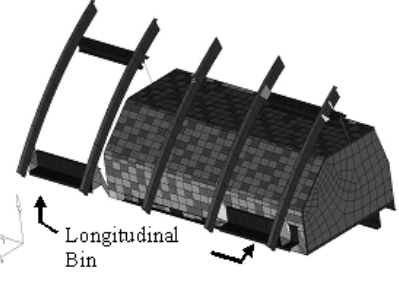
Fig. 11. Back view of the bin attachments to